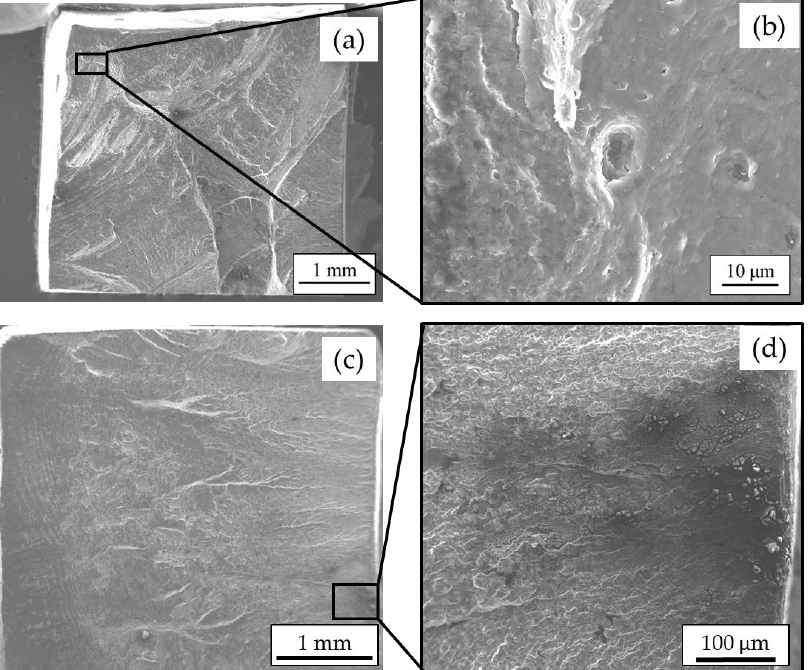
Figure 7. Fracture surface of ( a ) AFS-D as-deposited build direction sample tested at ε a = 0.3% ( N f = 6505 cycles) with ( b ) high-magnification view of a crack initiation site, and fracture surface of ( c ) AFS-D as-deposited longitudinal direction sample tested at ε a = 0.3% ( N f = 67,983 cycles) with ( d ) higher-